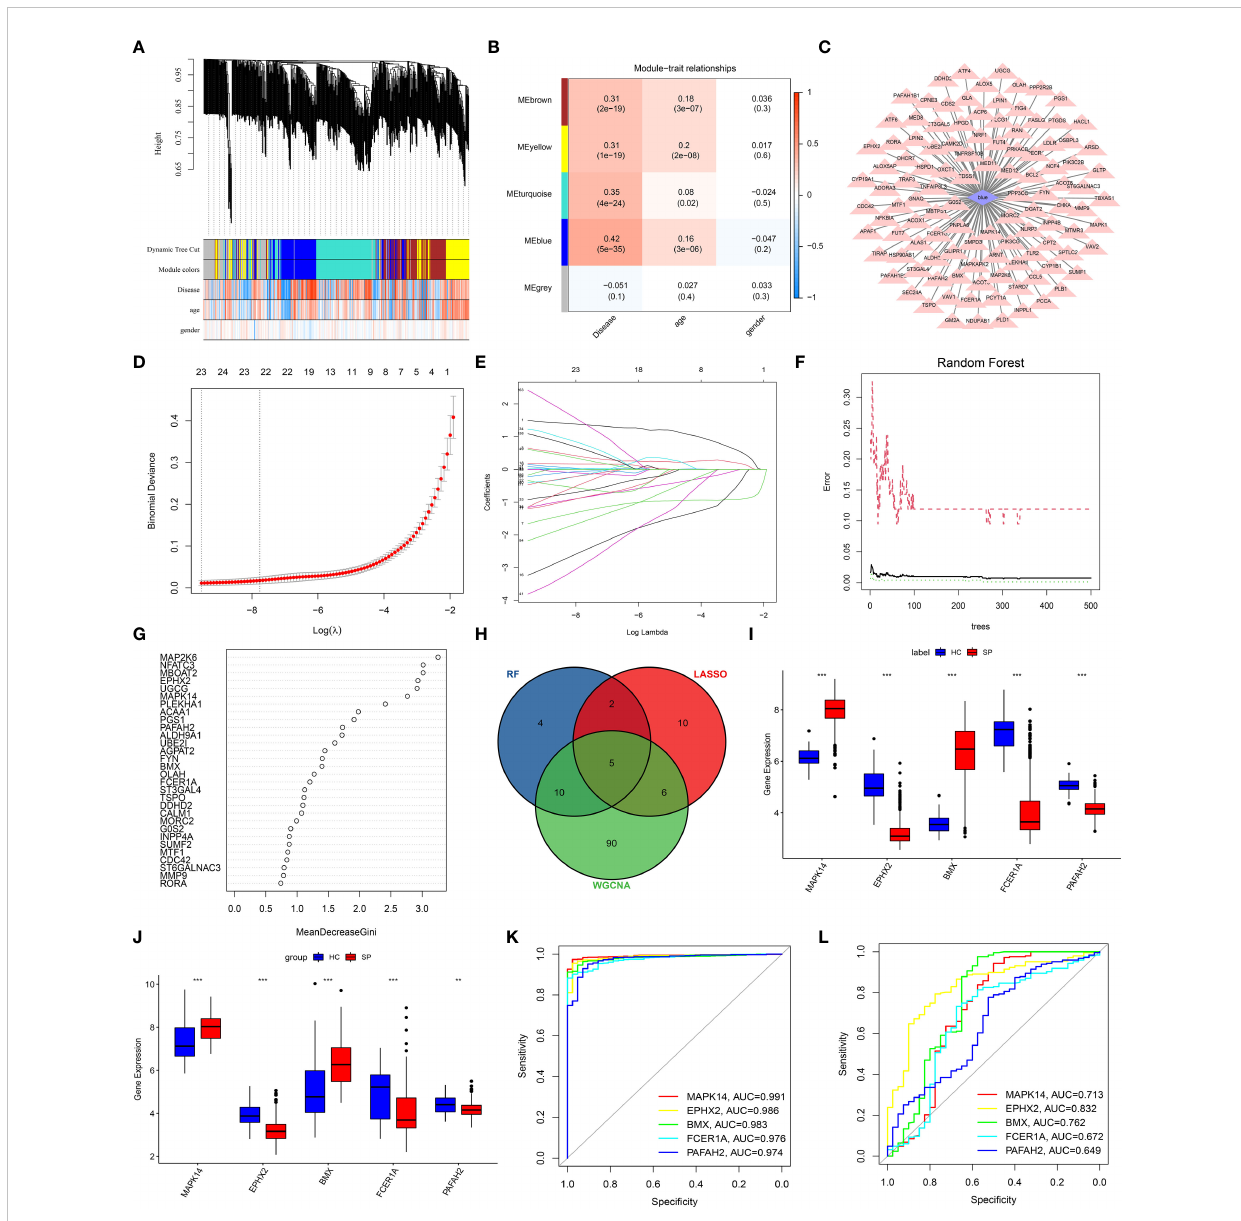
FIGURE 3 Screening of DE-LMRGs via the comprehensive strategy. (A) Clustering dendrogram of differentially expressed genes related to sepsis. (B) Heatmap between the correlation between modules and disease (Each cell contained the correlation coef fi cient and corresponding P-value). (C) The gene signi fi cance for sepsis in the blue module. (D, E) Least absolute shrinkage and selection operator (LASSO) logistic regression algorithm to screen DE- LMRGs. Different colors represent different genes. (F, G) Based on random forest (RF) algorithm to screen DE-LMRGs. Genes with an importance score greater than 1 were used for subsequent signature establishment. (H) VENN diagram of hub genes. (I, J) Validation of expression of hub genes in patients with sepsis and normal control in the training cohort and the validation cohort. (K, L) ROC of hub genes in the training cohort and the validation cohort. **: as compared with the Control group, P < 0.01; ***: as compared with the Control group, P